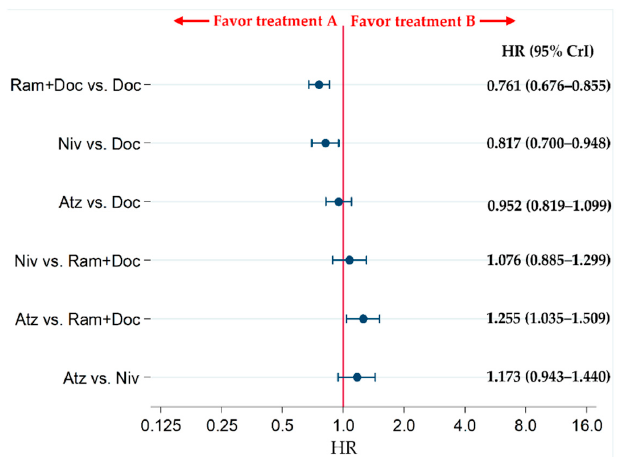
Figure 6. Comparing the progression-free survival (PFS) of patients with refractory or relapsed advanced non-small-cell lung cancer in the Ram+Doc, Doc, Niv, and Atz groups. The patient inclusion criteria for all RCTs in this analysis did not place any limitations on PD-L1 status. Comparisons are represented as treatment A versus treatment B. Data are presented as HRs (95% CrIs). Ram+Doc (ramucirumab plus docetaxel); Doc (docetaxel); Niv (nivolumab); Atz (atezolizumab); HR (hazard ratio); CrI (credible interval).